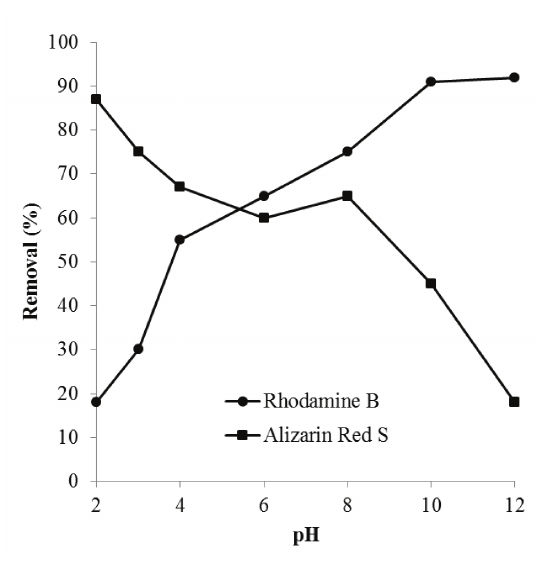
Fig. 6 – Effect of pH on the dye removal onto CES adsorbent (γ